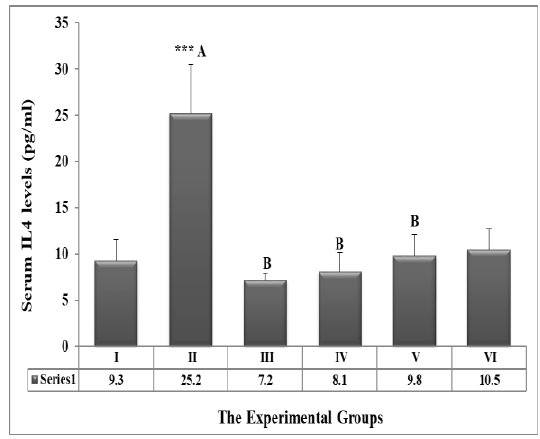
Figure.2. The effect of guggulsterone on IL4 levels in the serum of OVA-induced asthma in rats. Values are indicated as means ± Std. Error (n=8) for each group. Group I: Control group, Group II: Positive control group (with sensitization), Group III: Guggulsterone (25 mg/kg) with sensitization, Group IV: Guggulsterone (50 mg/kg) with sensitization, Group V: Prednisolone (4.12 mg/kg) with sensitization, Group VI: guggulsterone (50 mg/kg) without sensitization. *** symbol referred to significant different (p<0.001) compared to control group, unpaired test student t-test. Groups with non- identical letters are significantly different (p<0.05).